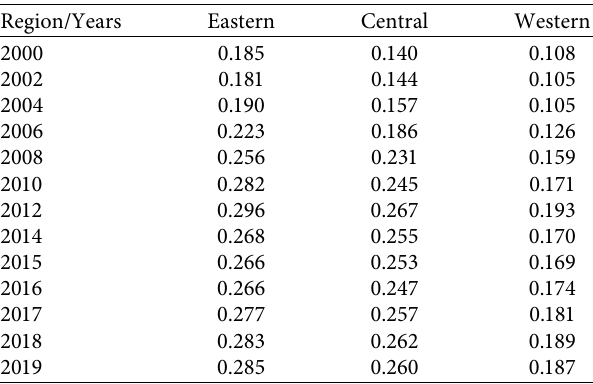
Table 3: Evaluation results of the comprehensive transportation development level in three regions of